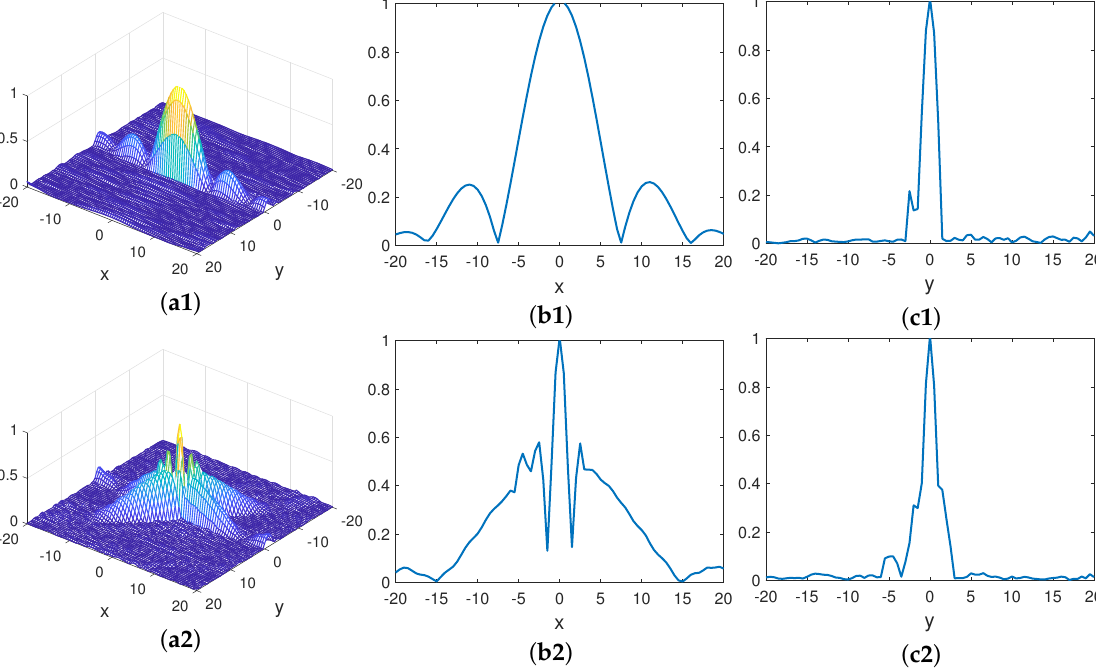
Figure 9. The correlation function of mono-static and bi-static MSCI. ( a 1, a 2) The space correlation function of mono-static and bi-static MSCI; ( b 1, b 2) the X-axis profile of the space correlation function of mono-static and bi-static MSCI; ( c 1, c 2) the Y-axis profile of the space correlation